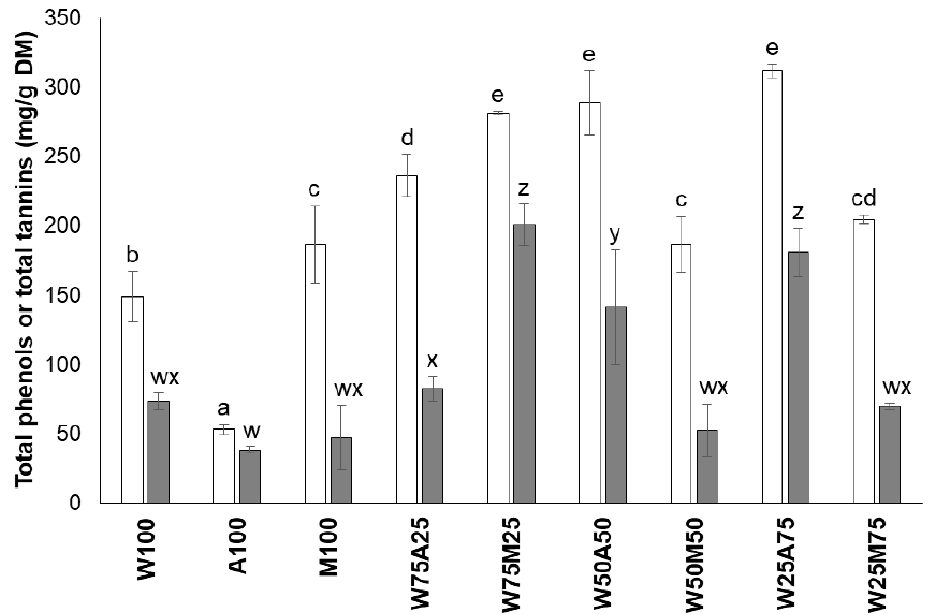
Figure 1. Concentrations of phenols (empty bars) and tannins (grey bars) in the DM of Swietenia mahogani leaf extracts obtained with different solvents (W: water; M: methanol; A: acetone; and numbers describe percentages of the respective solvents used). Bars carrying no common letter within the same parameter are different at p < 0.05.